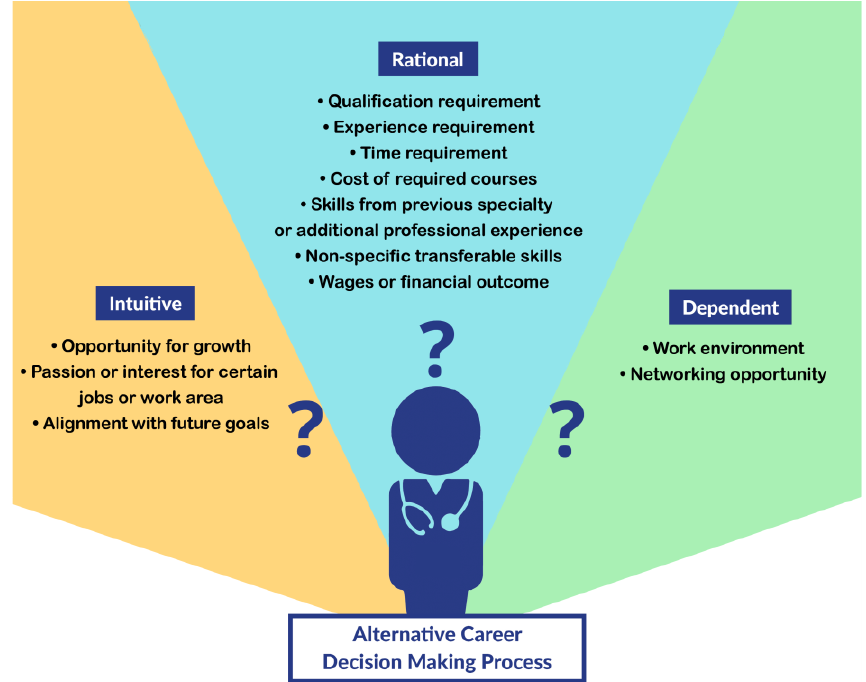
Figure 1. The alternative career decision-making process for IEPs.